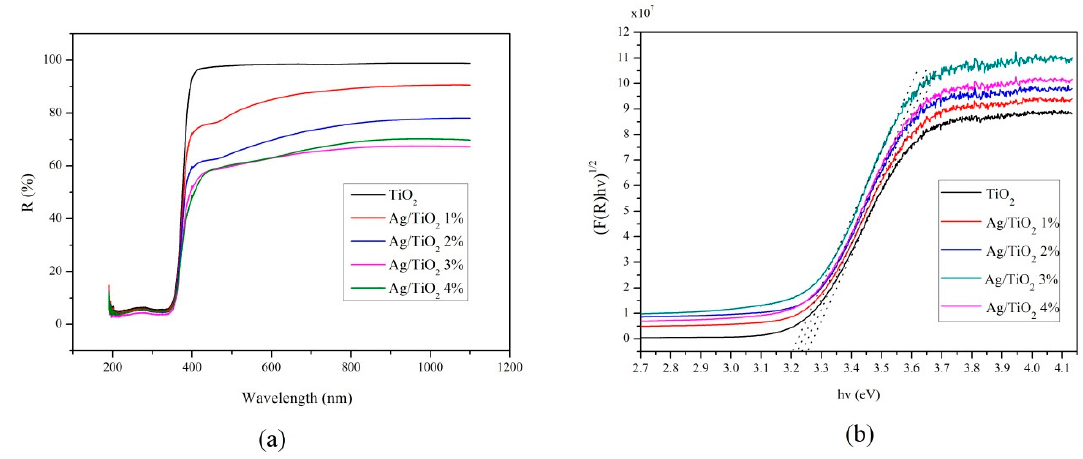
Figure 3. ( a ) Diffuse reflectance spectra and ( b ) band gap calculation of TiO 2 and Ag/TiO 2 X% (X = 1– 4).